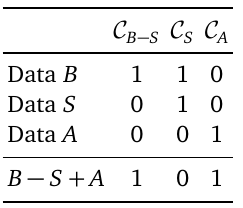
Table 1: Category assignment for a combined addition and subtraction of three sam-